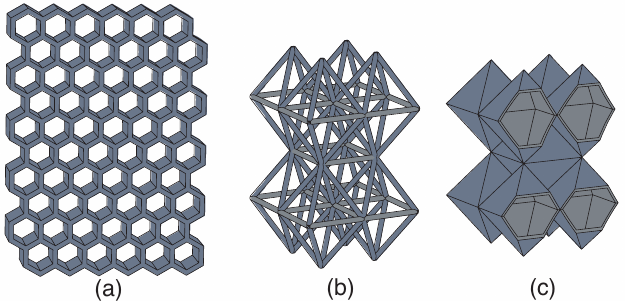
Figure 3. Typical cellular structures: ( a ) 2D cellular structure known as “Honeycomb”, ( b ) 3D open-cell structure (lattice structure), and ( c ) 3D closed-cell structure. The structures in subfigures ( b , c ) are 3D structures termed as